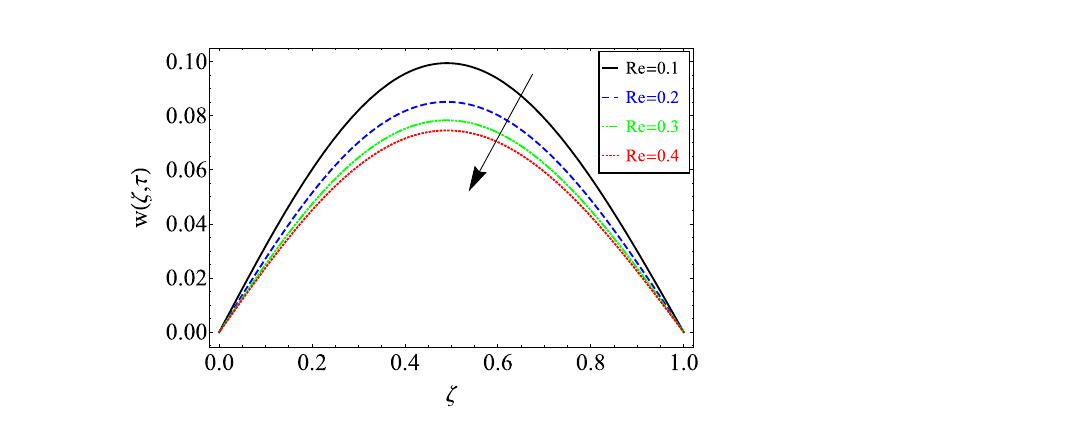
Figure 6. The effect of different values of Re on velocity distribution of Maxwell nanofluid, when α = 0.7 , τ = 0.5 , φ = 0.02 , Gm = 0.5, Gr = 0.05 , Pr = 6300 , Sc = 15 and (cid:31) = 0.5 .